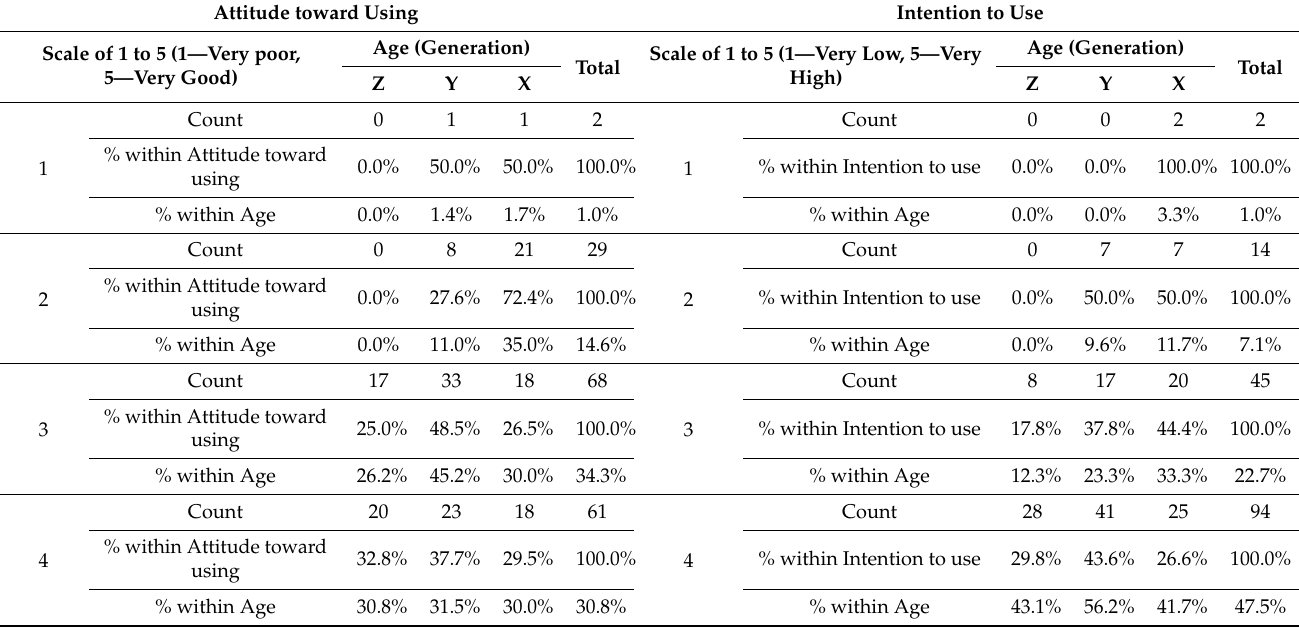
Table 7. The association between the variable age and the variables attitude toward using and intention to use. Attitude toward